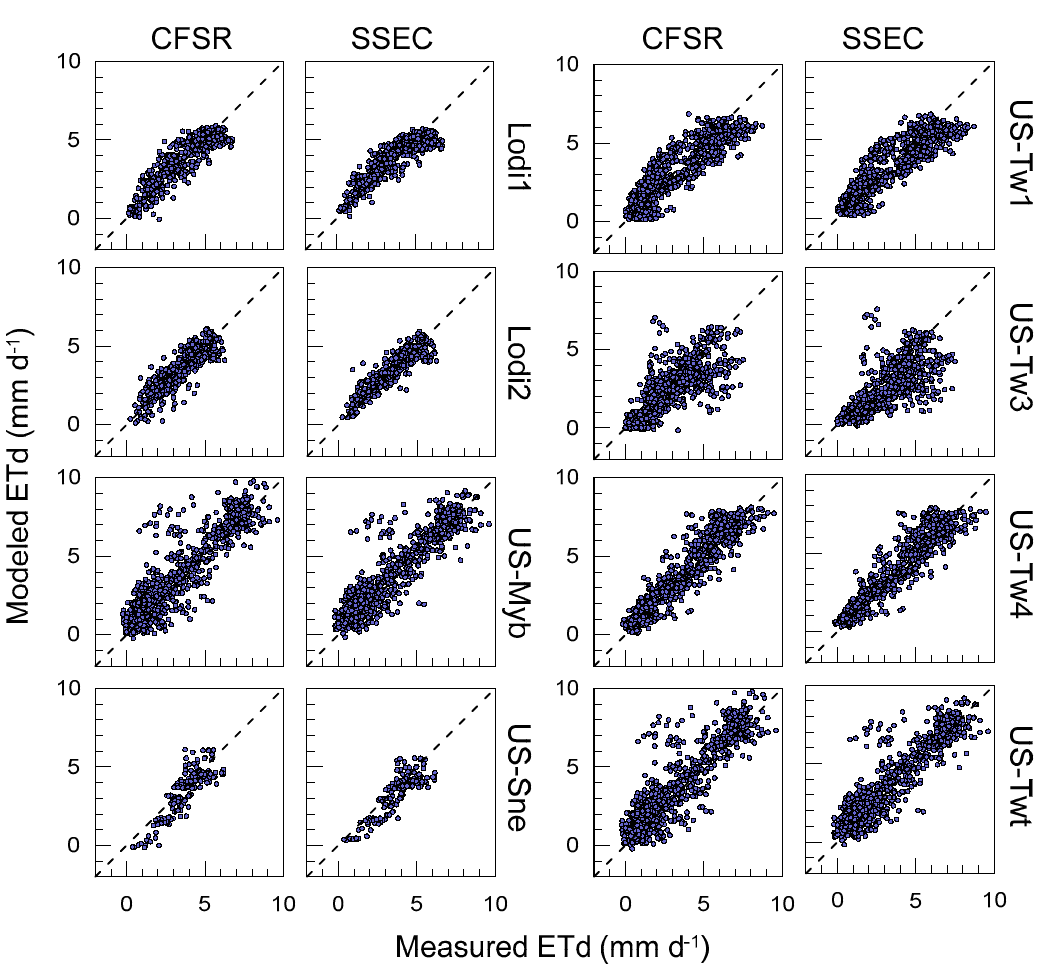
Figure 9. Comparison of daily observed and modeled ET fluxes generated using the CFSR and SSEC insolation datasets.